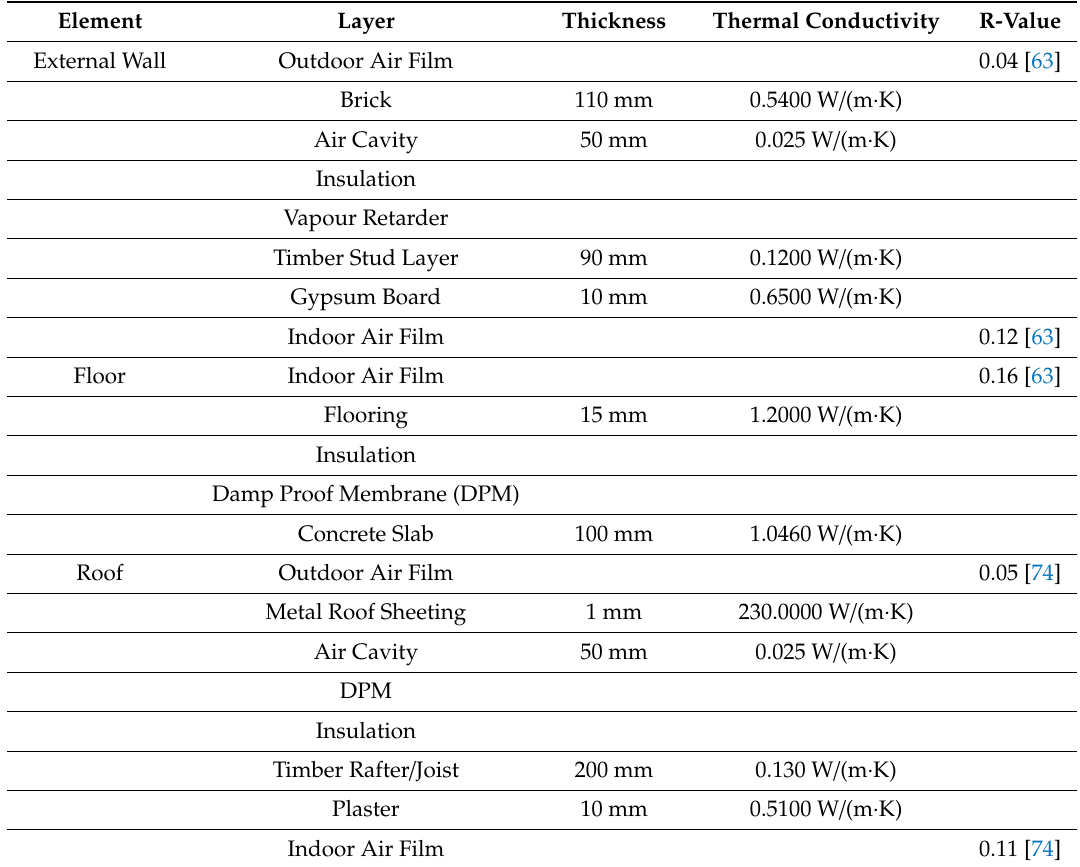
Table 2. Building Envelope Assembly Details.